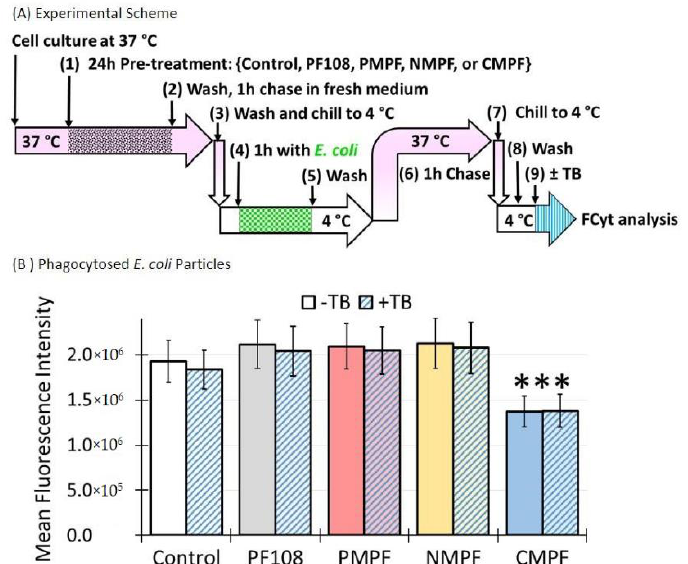
Figure 7. A 24 h exposure of RAW 264.7 cells to C-MWNTs, but not P- or N-MWNTs, impairs subsequent phagocytosis of E. coli . RAW 264.7 cells were incubated in media containing 100 µ g / mL of P-, N-, or C-MWNTs, or 0.1 mM PF108 alone at 37 ◦ C for 24 h. The cells were chilled to 4 ◦ C and exposed to heat-killed Alexa Fluor ® 488-conjugated E. coli , at 30 E. coli particles per cell, for 1 h at 4 ◦ C, washed, chased for 1 h at 37 ◦ C to allow phagocytosis, washed again, and analyzed by FCyt as described in Methods. Cells with a fluorescence intensity greater than the background auto-fluorescence were considered positive for phagocytosed E. coli . Flow cytometric measurements of a sample were followed immediately by consecutive analysis in the presence of 0.1% trypan blue dye, as described in Methods. ( A ) The timeline scheme outlines the key experimental steps. ( B ) E. coli phagocytosed by untreated control, PF108-treated, MWNT-treated cells. Mean fluorescence intensity was measured in the absence ( − TB) and subsequent presence ( + TB) of 0.1% trypan blue. *** is for p < 0.0005. Data are the mean ± SD of triplicate measurements per sample in ≥ 3 independent experiments.